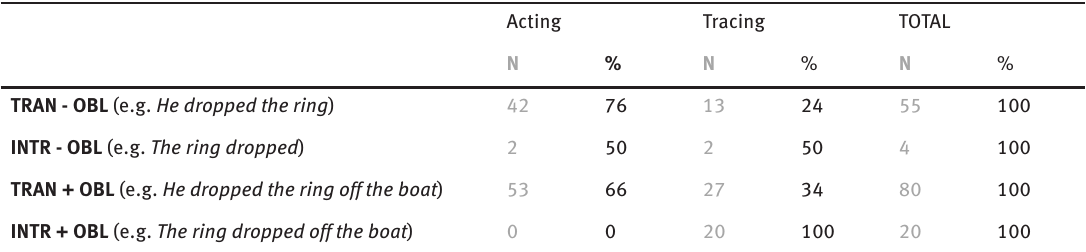
Table 7. Gestural Modes of Representation with respect to the causative-inchoative alternation with/without directional